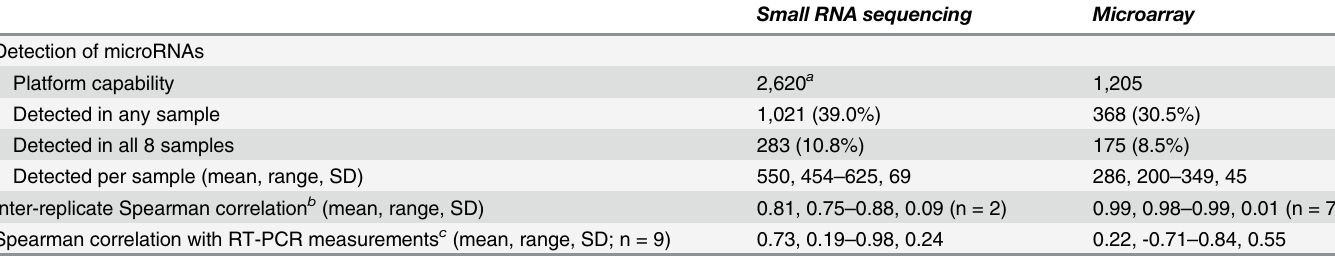
Table 3. Comparison of the small RNA sequencing and microarray